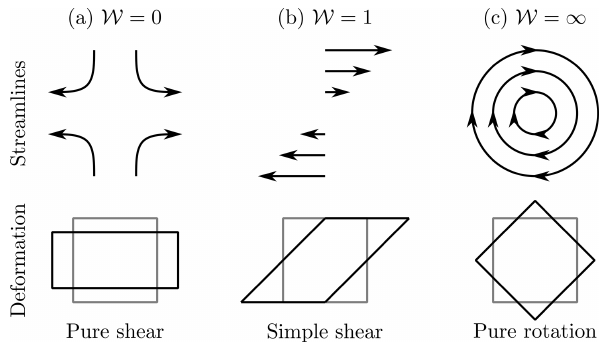
Figure 2. Schematics illustrating two-dimensional flow regimes at different vorticity numbers W (Eq. 1): (a) Pure shear ( W = 0 ) , (b) Simple shear ( W = 1 ) , (c) A pure rotation deformation ( W = ∞ ) . For each flow the streamlines and deformation regime pro- duced are